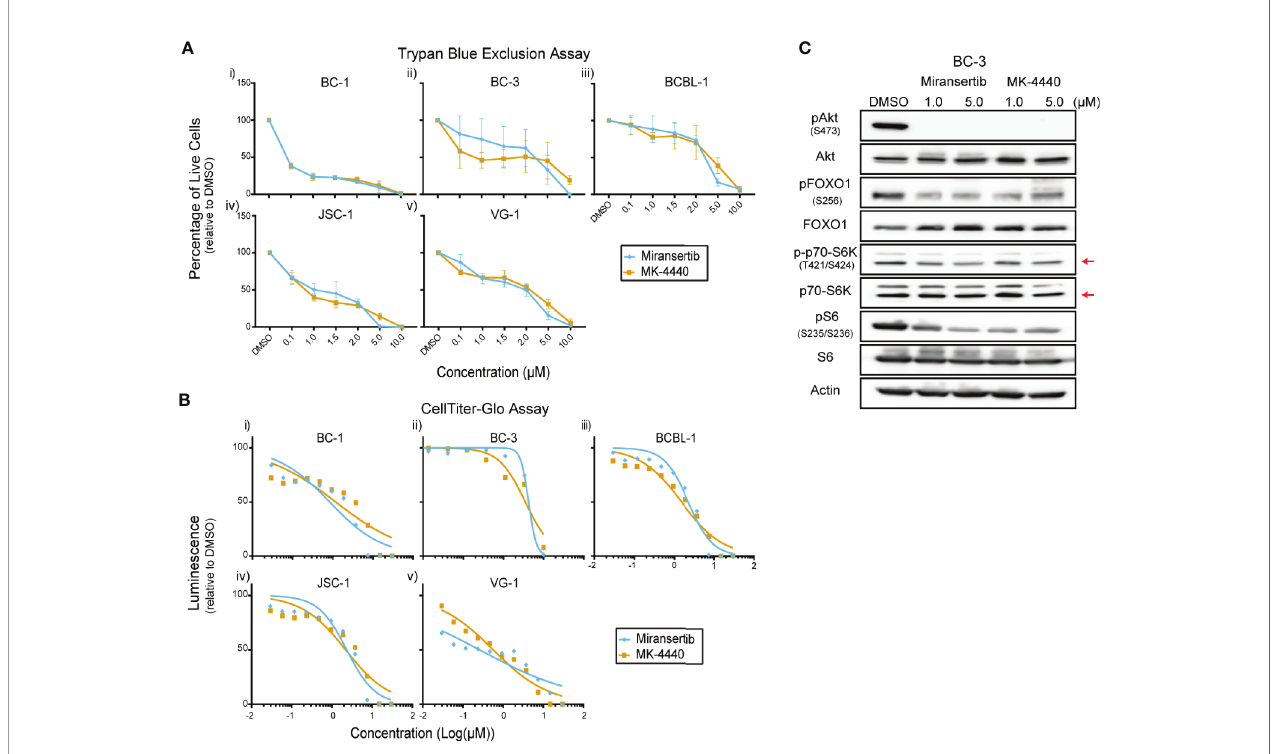
FIGURE 5 | Inhibition of Akt by miransertib or MK-4440 reduces the viability of primary effusion lymphoma cells. (A) The PEL cell lines BC-1 (i), BC-3 (ii), BCBL-1 (iii), JSC-1 (iv), VG-1 (v) were treated for 72 h with miransertib, or MK-4440, and live cells were counted by excluding dead cells stained with trypan blue. (B) The PEL cell lines BC-1 (i), BC-3 (ii), BCBL-1 (iii), JSC-1 (iv), VG-1 (v) were treated for 72 h with miransertib, or MK-4440, and CellTiter-Glo was used to measure viability. (C) A representative PEL cell line, BC-3, was treated for 24 h with miransertib or MK-4440, and immunoblots were performed as in Figure 1C . The red arrow points to the p70-S6K